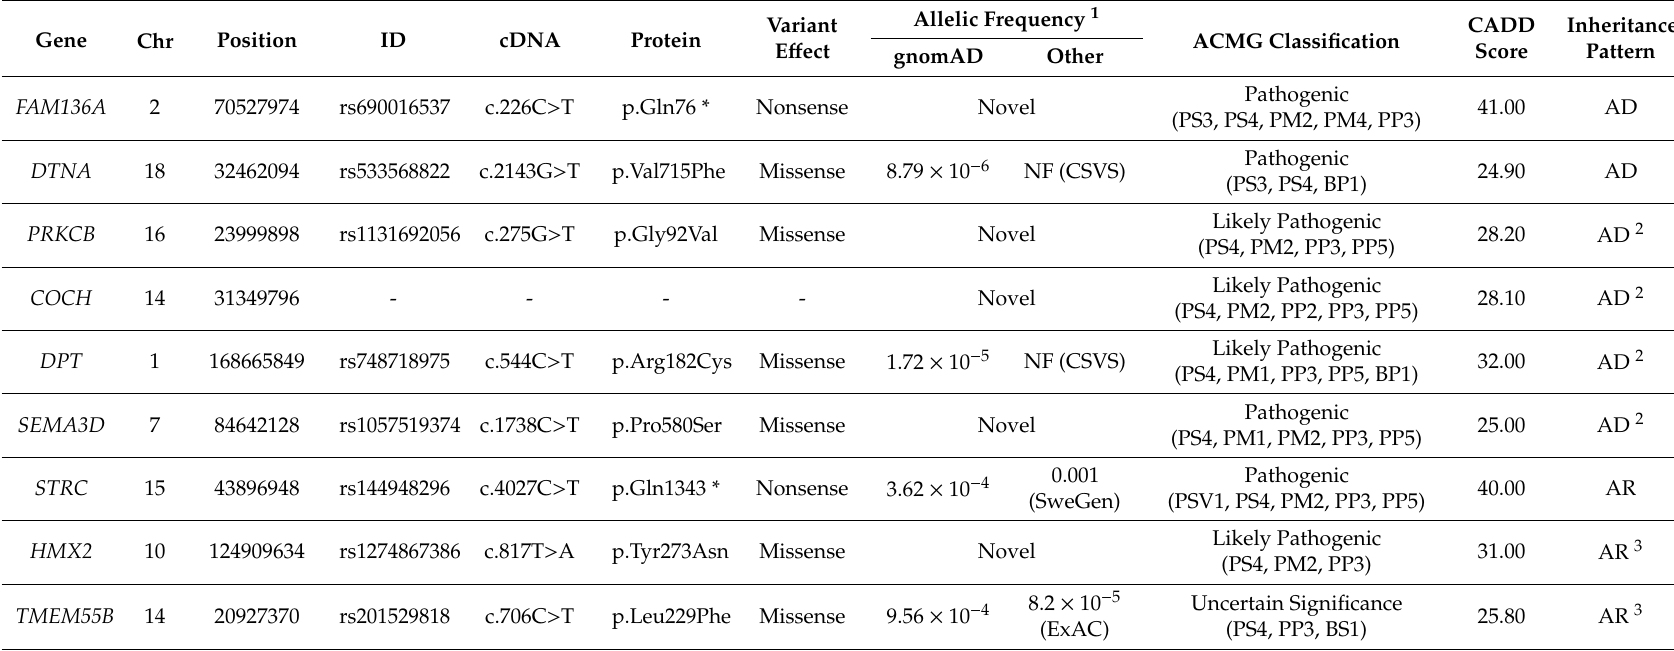
Table 2. Genetic findings for each SNV (single nucleotide variant), pathogenicity and inheritance